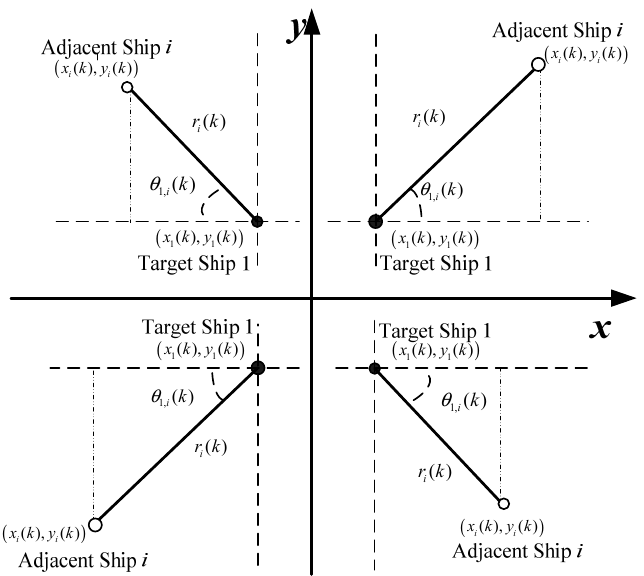
Figure 1. The adjacent ships around the target ship.